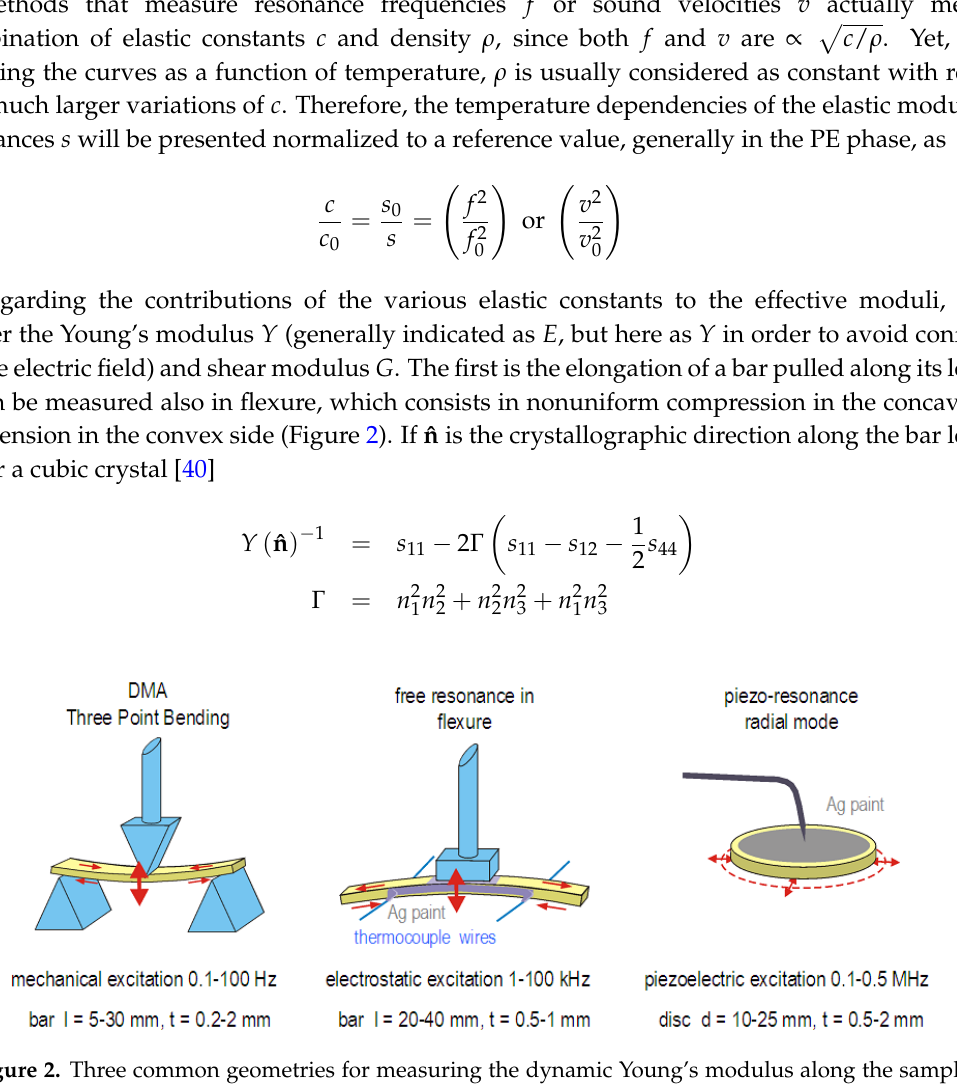
Figure 2. Three common geometries for measuring the dynamic Young’s modulus along the sample length or radially. Also indicated are typical sizes of the samples and driving/resonance